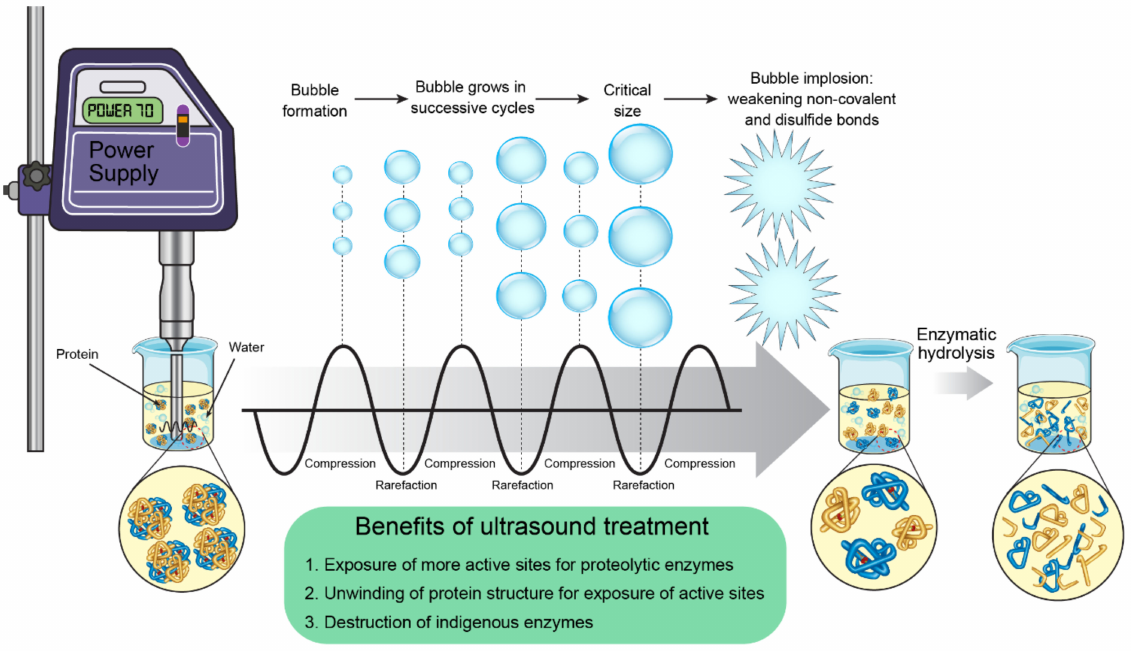
Figure 3. Schematic illustration of ultrasound-assisted proteolysis of food